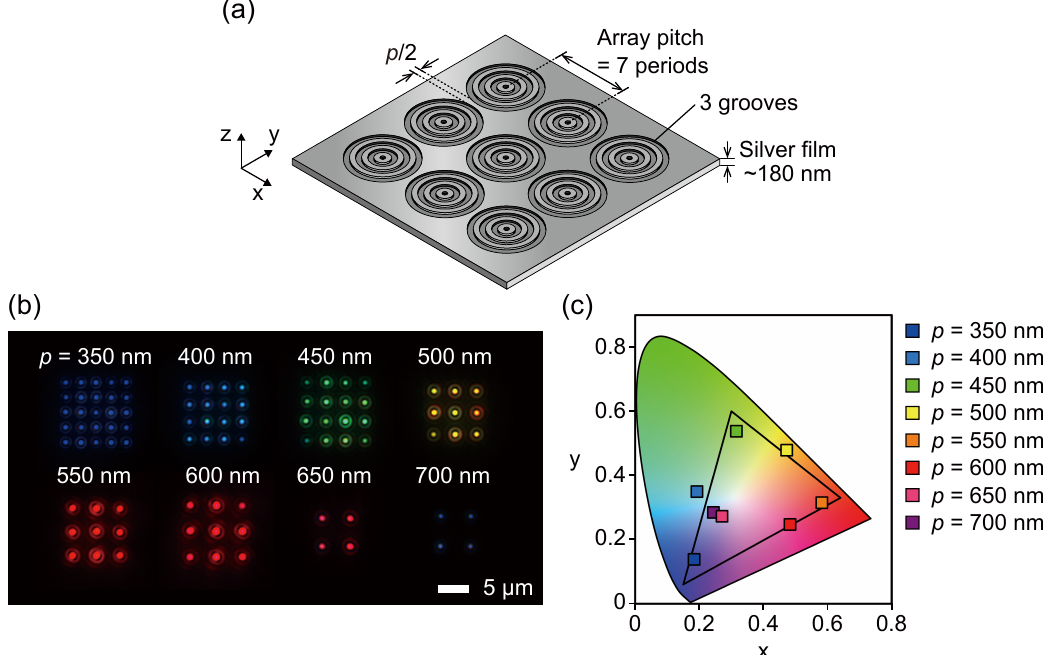
Figure 7. ( a ) A schematic of a 10 µ m × 10 µ m plasmonic color filter array with groove number N = 3. ( b ) Darkfield micrographs of fabricated plasmonic color filter arrays for p = 350–700 nm. ( c ) CIE1931 XY chromaticity diagram of the measured transmission spectra of the